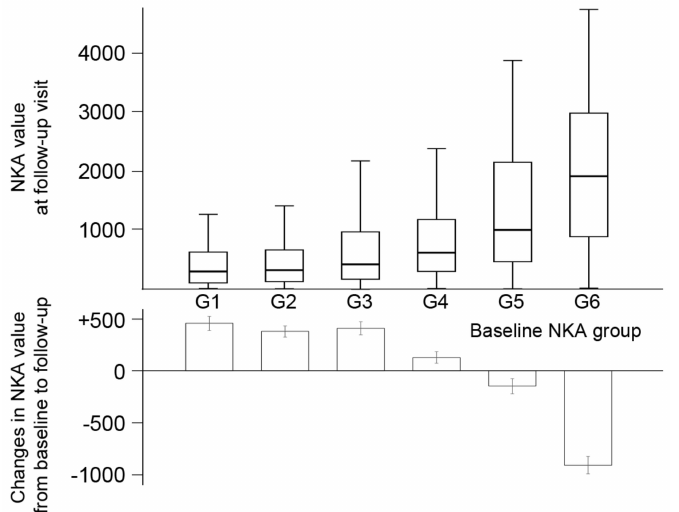
Figure 3. The changes in natural killer cell activity according to the baseline natural killer cell activity classification. Box plots show the median, interquartile range, and minimum/maximum (except for outliers) of NKA at follow-up visit. Bar charts show the mean of the changes in NKA, and the error bars express standard errors. G1–6 represents natural killer cell activity classification (G1, <100; G2, 100–250; G3, 250–500; G4, 500–1000; G5, 1000–2000; G6, ≥ 2000). NKA, natural killer cell